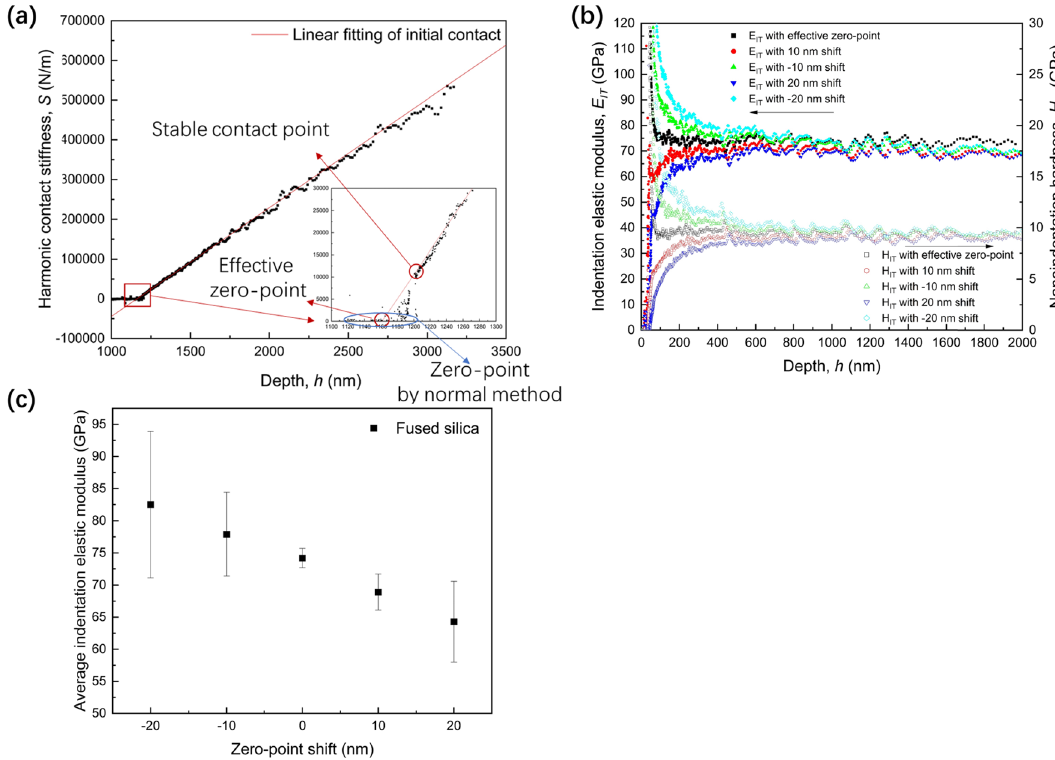
Figure 2. Zero-point adjustment and results on fused silica, and the impact of the zero-point shift on indentation elastic modulus. ( a ) Linear fitting and extrapolation on nanoindentation data to determine the effective zero-point. Red circle and blue circle show the possible zero-point by proposed method and stiffness criterion, respectively. ( b ) Indentation elastic modulus results after zero-point adjustment. ( c ) Indentation elastic modulus and nanoindentation hardness after zero-point shift. ( d ) Average and standard deviation of indentation elastic modulus after zero-point